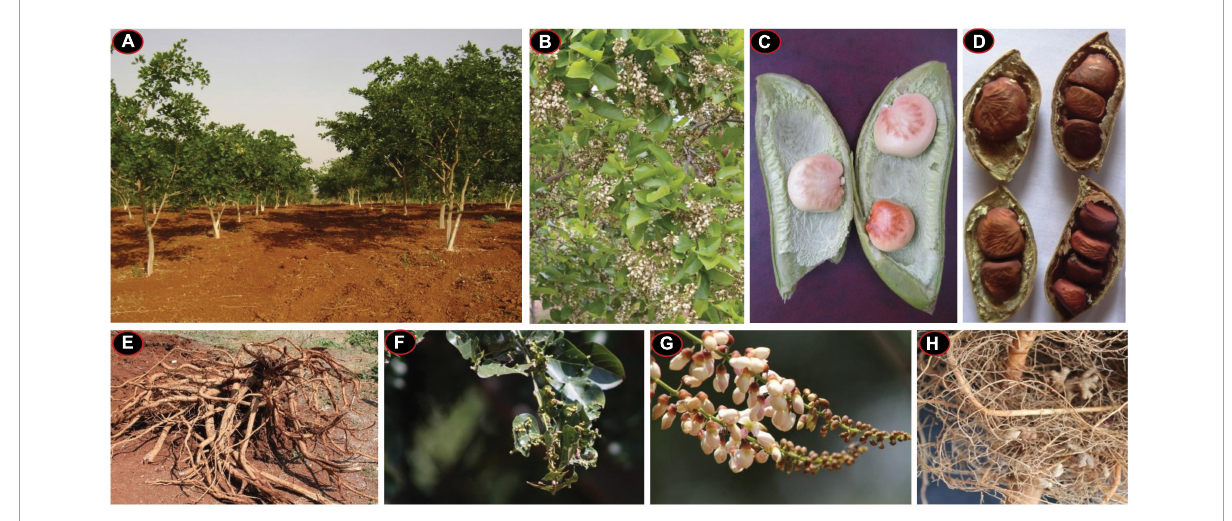
FIGURE1 Morphological and phenological characteristics of a typical pongamia plant. (A) Pongamia pinnata plantation in an experimental farm. (B) Pongamia at a full-bloom stage. (C) An immature pod with a typical seed-arrangement pattern. (D) Mature pods bearing varied number of seeds. (E) Root biomass harvested. (F) Characteristic leaf buds of pongamia. (G) The Racemose type of inflorescence in pongamia. (H) Root nodules of